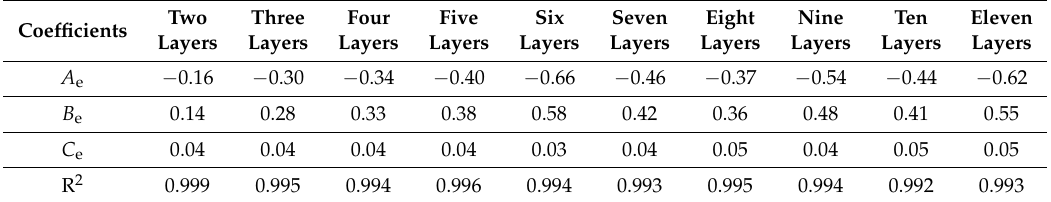
Table 3. Fitting coefficients for total charge quantity at steady state (1800 s) under different electrical field strengths for multi-layer oil-paper insulation.